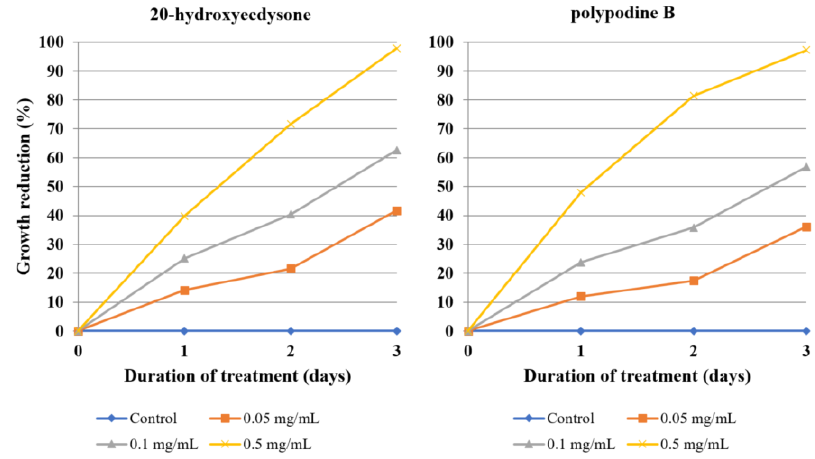
Figure 6. The effect of 20-hydroxyecdysone and polypodine B isolated from Lychnis flos-cuculi L. on the inhibition of Acanthamoeba trophozoite proliferation in the culture medium.